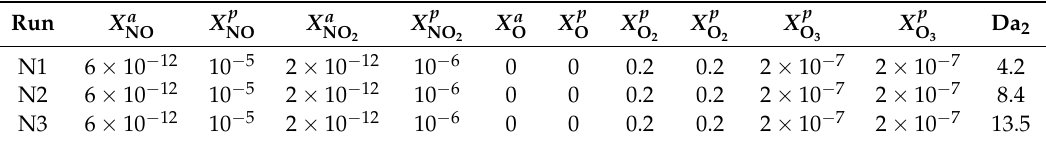
Table 2. Parameters of the initial distribution of species mixing ratios of Equation (49) and initial Damk¨oler number for various runs and the simplified NO x chemistry